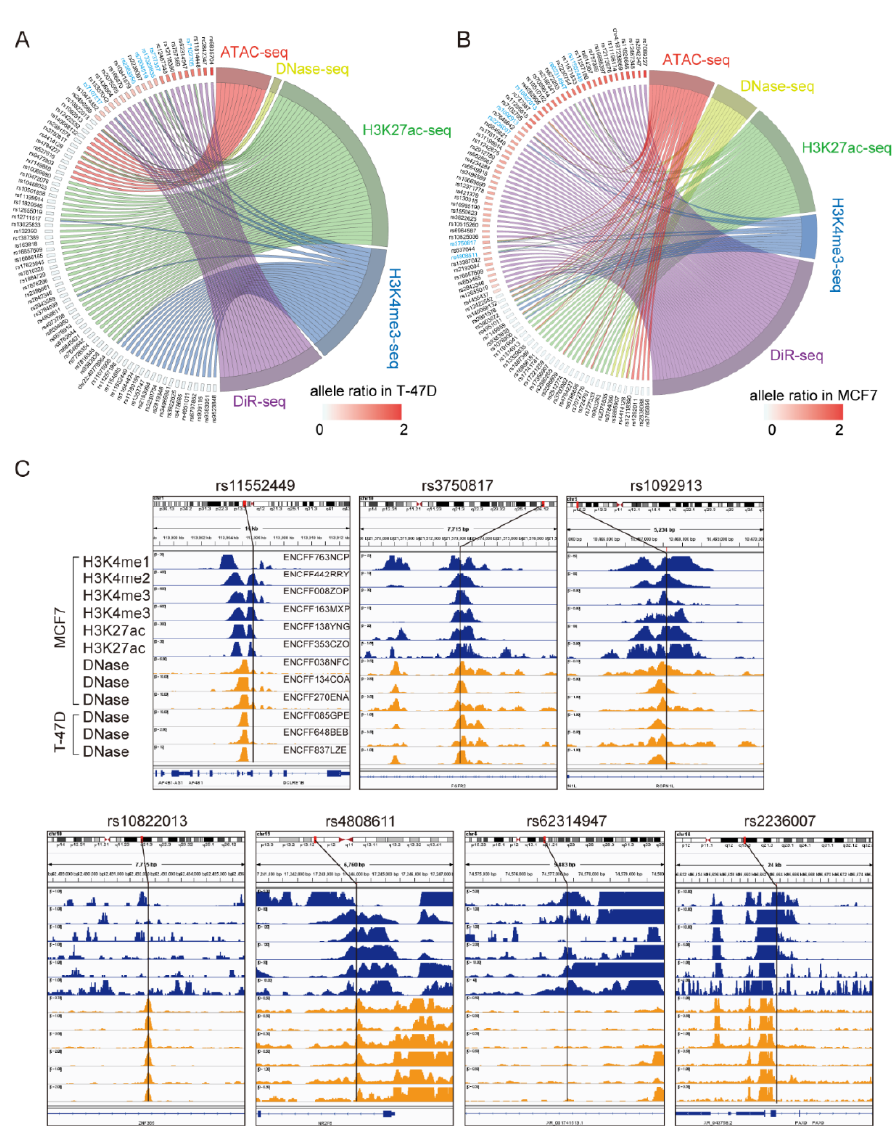
Figure 2. Multi ‐ omics analysis nominated the seven most plausible functional variants. ( A ) Chord plot depicts the putative functional SNPs in DiR ‐ seq analysis of T ‐ 47D cells and relevant omics signatures, including ATAC ‐ seq (GSE120162), Dnase ‐ seq (ENCFF106BSS), H3K27ac ‐ seq (GSM2862200) and H3K4me3 (GSM2862200) obtained from ENCODE database or GEO database. Six functional SNPs nominated in T ‐ 47D cells were shown in blue. ( B ) Chord plot depicts the putative functional SNPs in DiR ‐ seq analysis of MCF7 cells and relevant omics signatures, including ATAC ‐ seq (ENCFF817LPT), Dnase ‐ seq (ENCFF414CWD), H3K27ac ‐ seq (ENCFF277GNV) and H3K4me3 (ENCFF237HYI) obtained from ENCODE database. Seven SNPs picked out in MCF7 cells were shown in blue. ( C ) Enrichment visualization for chromatin active marker at seven functional SNPs in MCF7 or T ‐ 47D. ChIP ‐ seq data for histone modification (H3K4me1; H3K4me2; H3K4me3; H3K27ac indicating enhancer marks) in MCF7 are shown in blue. DNase ‐ seq data in MCF7 and T ‐ 47D are shown in orange. All these data were obtained from ENCODE database, and the accession number of each experiment is shown in the first panel of rs11552449, including ENCFF837LZE, ENCFF648BEB, ENCFF085GPE, ENCFF270ENA, ENCFF134COA, ENCFF038NFC, ENCFF353CZO, ENCFF138YNG, ENCFF163MXP, ENCFF008ZOP, ENCFF442RRY and ENCFF763NCP. Genomic information is shown at the upper part, and gene information is shown at the lower part. The position of SNP in signal tracks is shown in a vertical line.